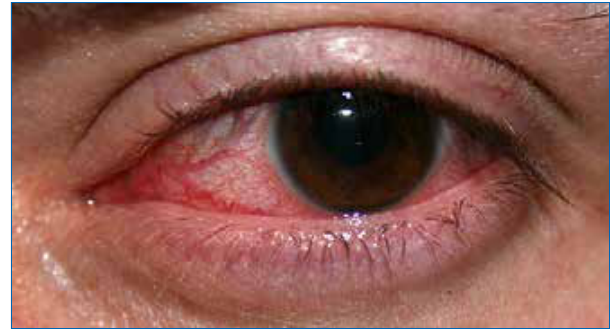
Figure 3: Eye with non-ulcerative sterile